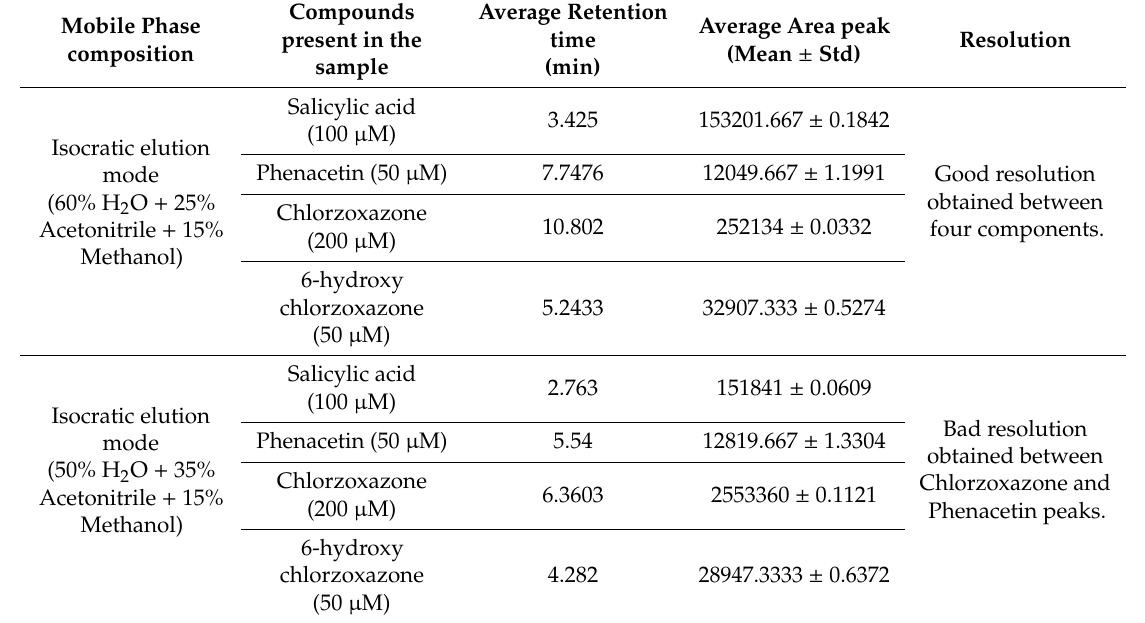
Table A2. Variation in retention time, and resolution between compounds when changing the composition of mobile phase.